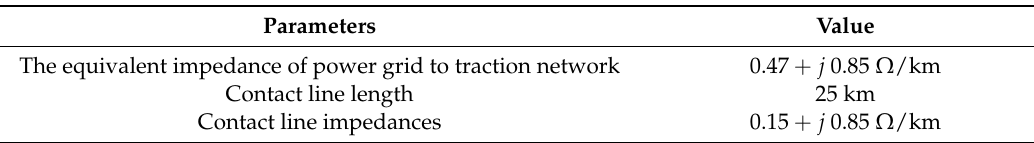
Table 2. Line parameters.